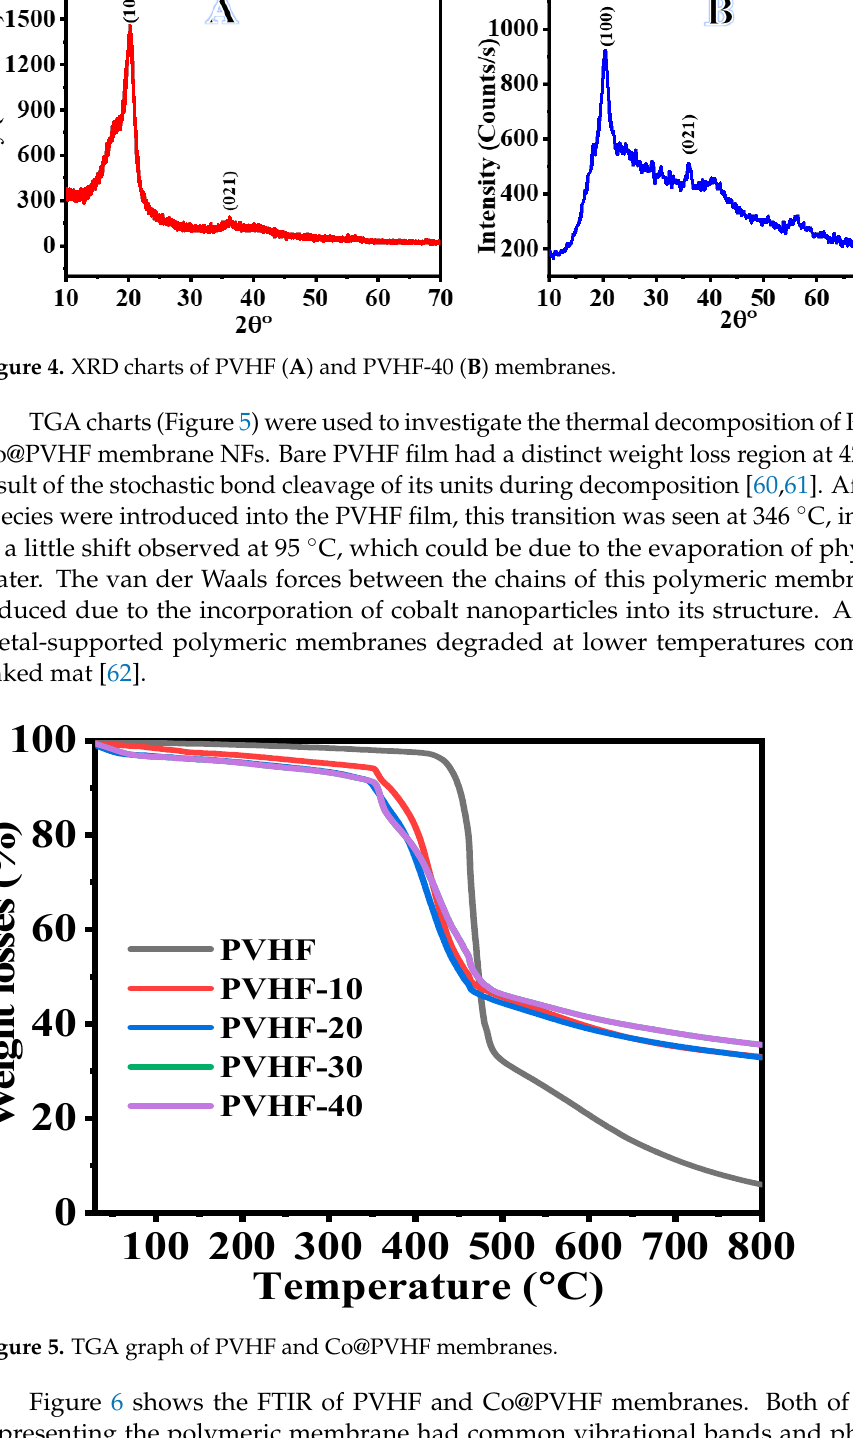
Figure 3. ( A ) SEM picture and ( B ) EDX graph of PVHF-40 membrane at different SEM image points. Figure 4 shows the results of an XRD analysis of PVHF-40 membrane crystallinity. In the XRD graph of the PVHF membrane, the three main diffraction planes were found at 2 theta of 20.49°and 36.18°, which correspond to the (100) and (021) planes, respectively [57]. On the other hand, XRD does not reveal any Co NPs in the sample, perhaps because the cobalt NPs are too tiny or amorphous [22,58,59].